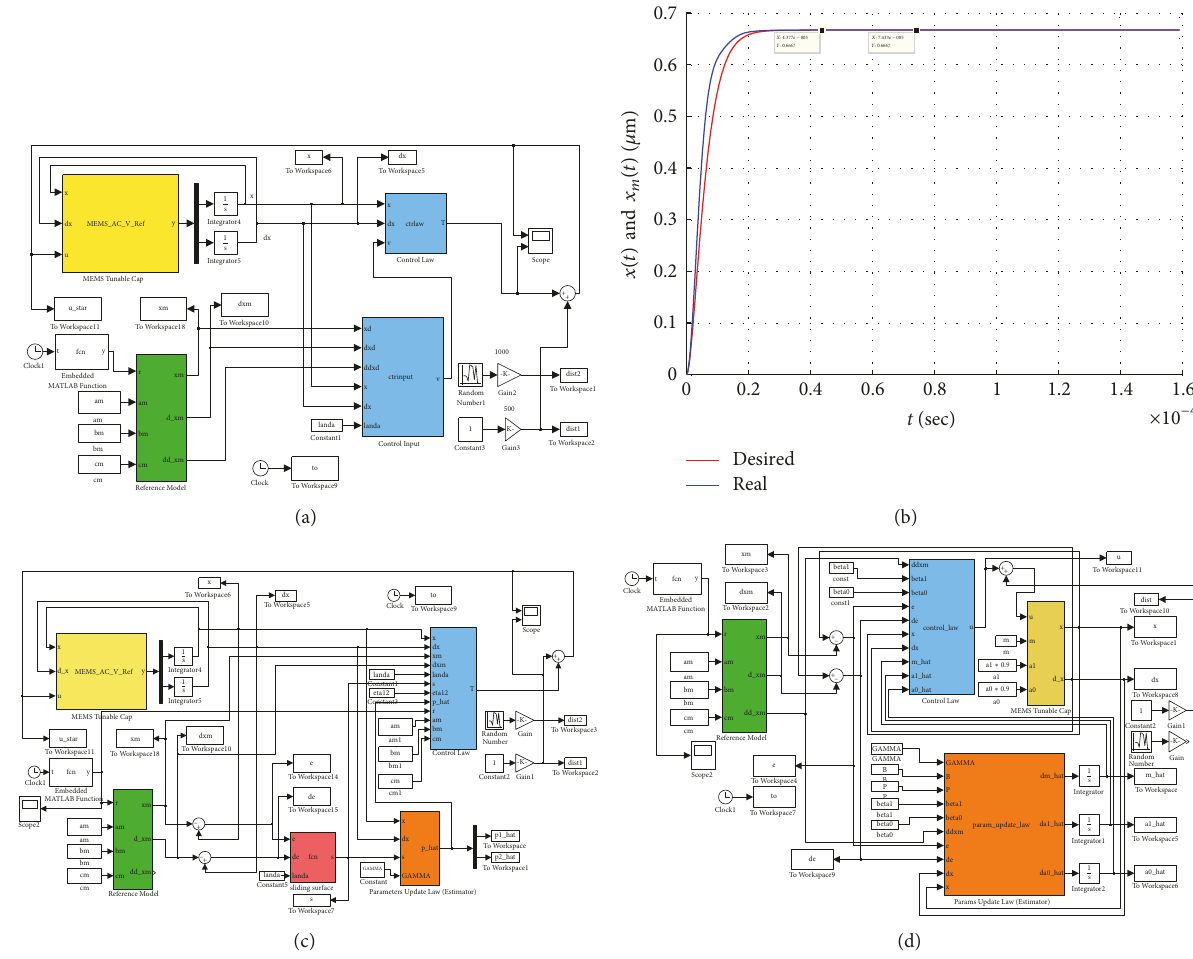
Figure 3: Simulation schemes of pole-placement state feedback controller, adaptive sliding mode, and conventional adaptive ones: (a) control scheme of the pole-placement state feedback controller; (b) tracking performance in the pole-placement state feedback controller under normal operating conditions; (c) adaptive sliding mode controller simulation scheme; (d) conventional adaptive controller simulation scheme